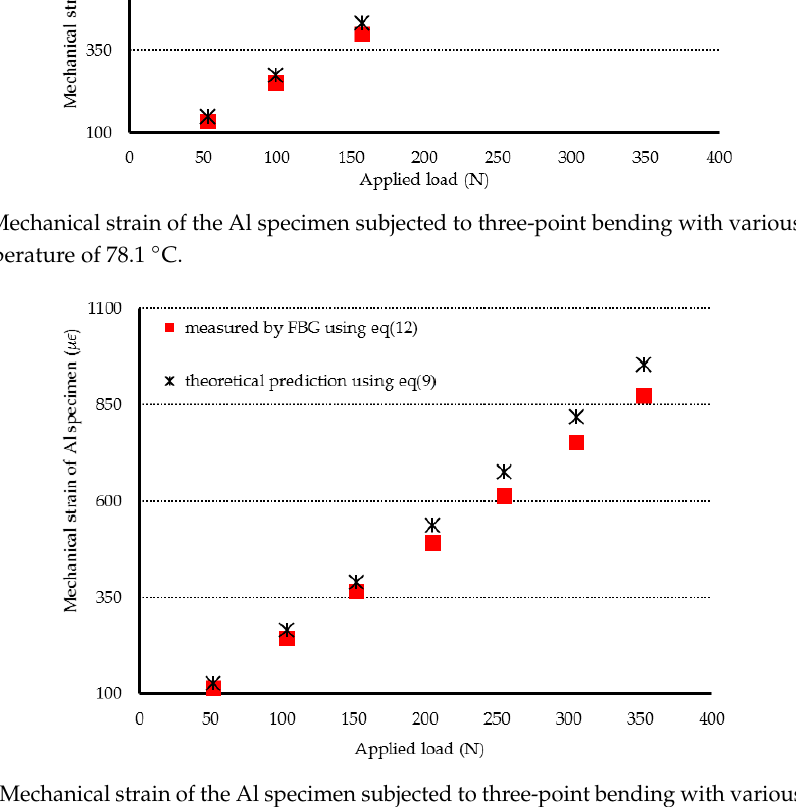
Figure 10. Mechanical strain of the Al specimen subjected to three-point bending with various loadings at a temperature of 96.5 °C.